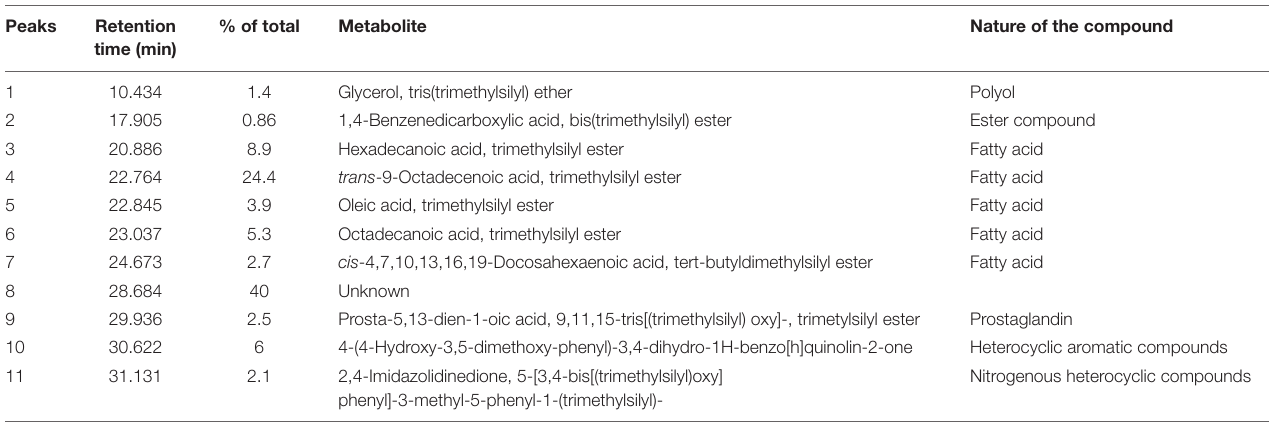
FIGURE 8 | GC-MS chromatogram of AUME. TABLE 2 | List of secondary metabolites in AUME analyzed by